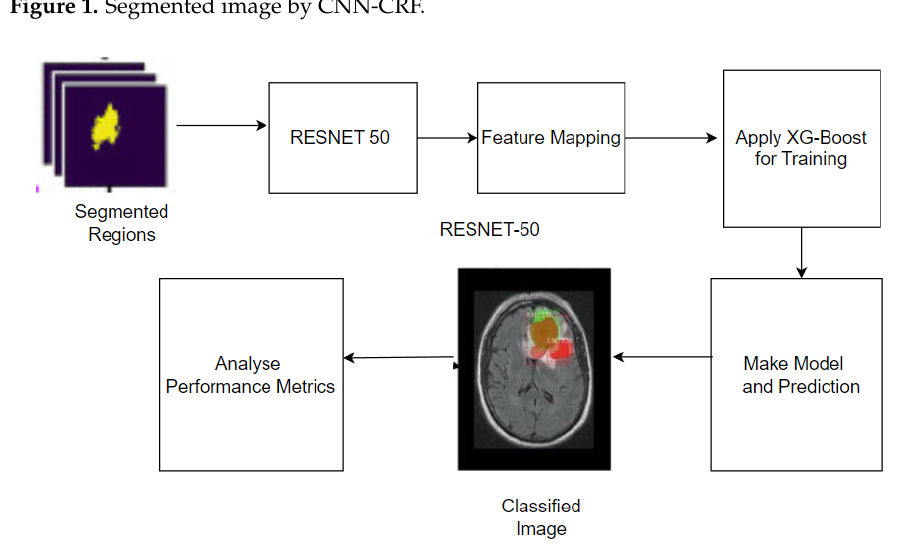
Figure 2. Classification and feature mapping framework Resnet-XG